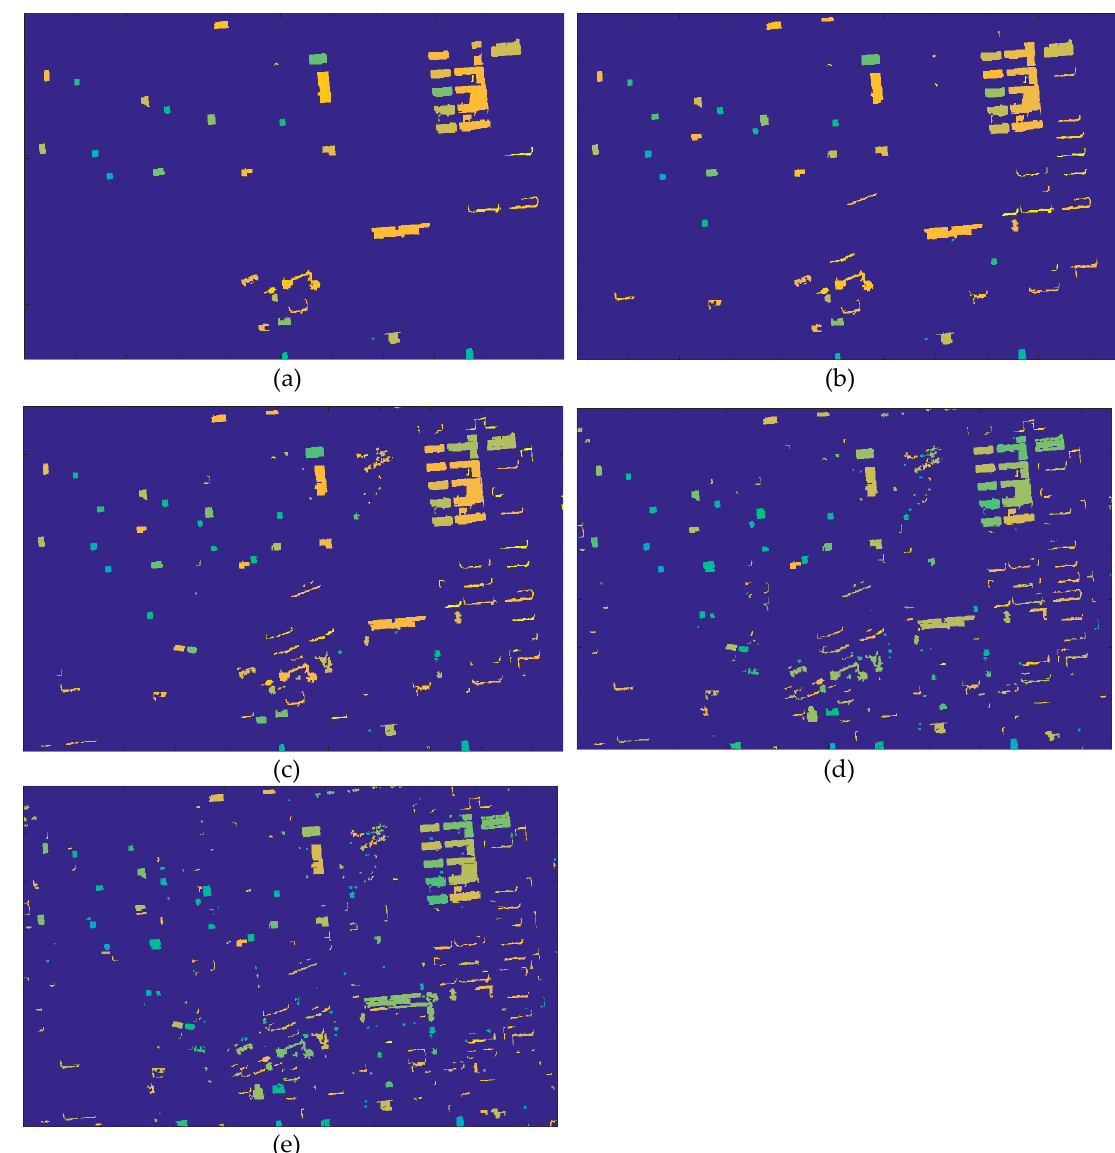
Figure 6. Shape similarity results under segmentation scale: ( a ) Q = 16, ( b ) Q = 32, ( c ) Q = 64, ( d ) Q = 128, and ( e ) Q =